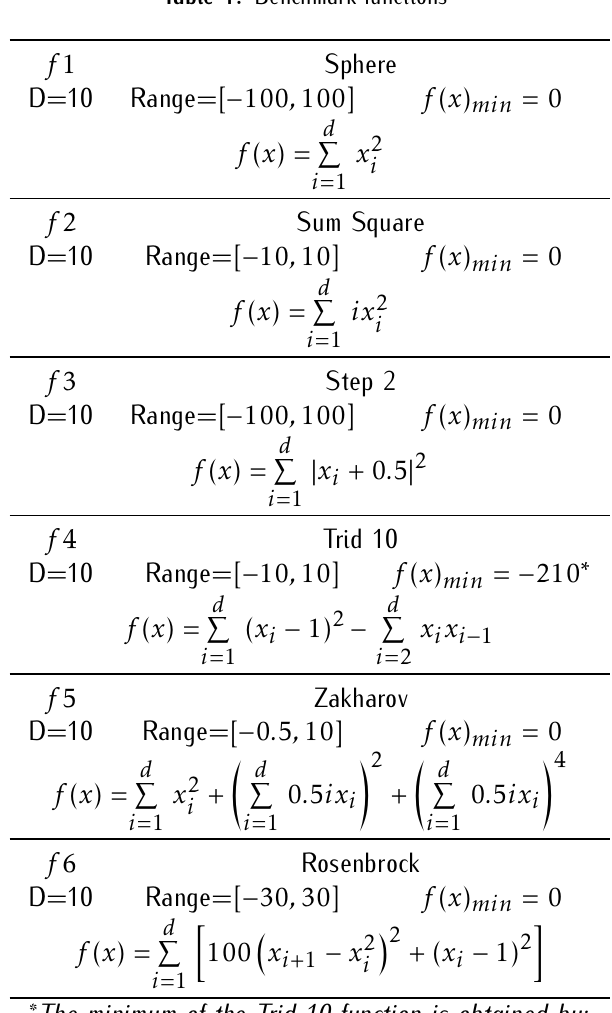
Table 1. Benchmark